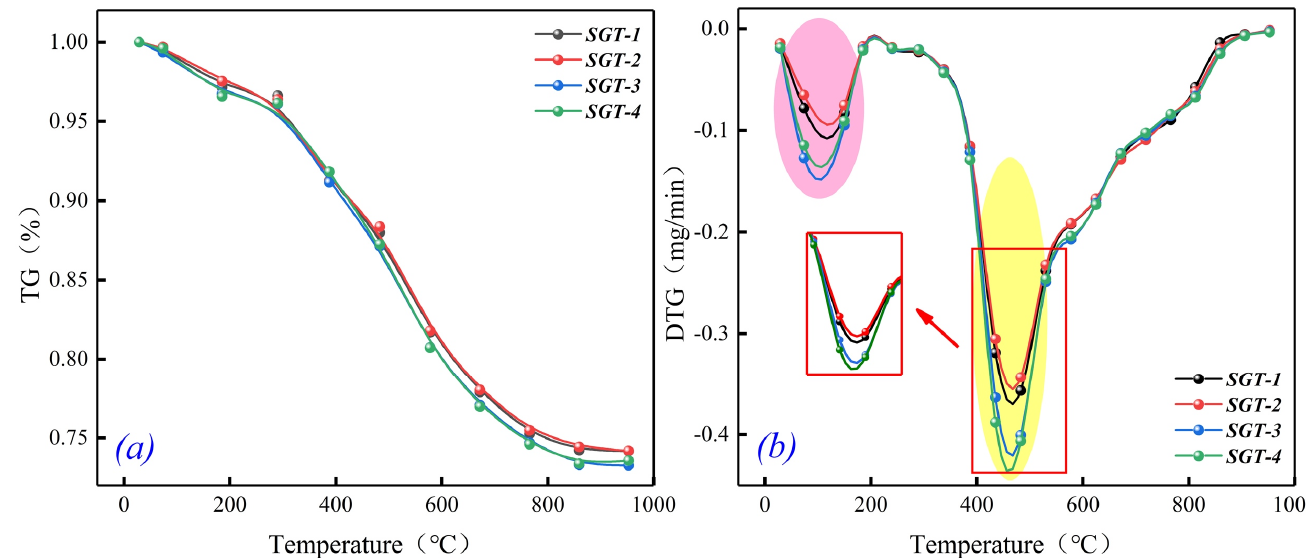
Figure 1. TG and DTG curves of coal samples ( a : TG curves, b : DTG curves).